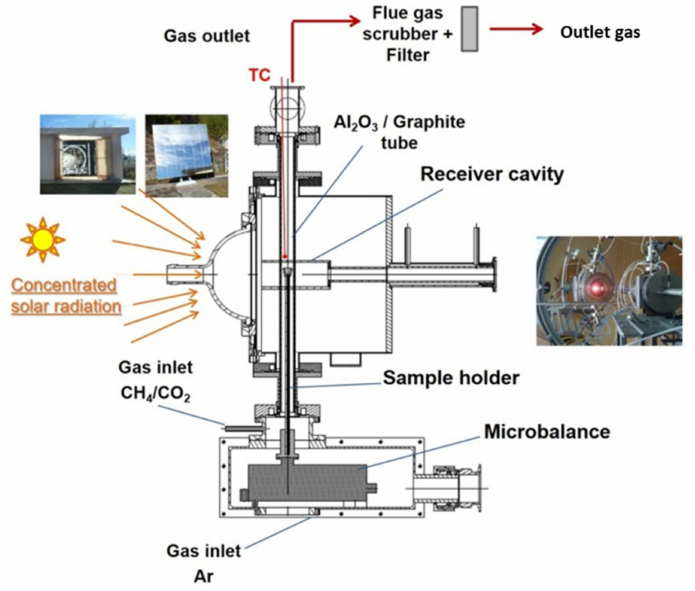
Figure 9. Schematic representation of the solar thermogravimetric reactor equipped with a parabolic dish concentrator, used for carrying out the thermochemical redox cycles over CeO 2 oxygen